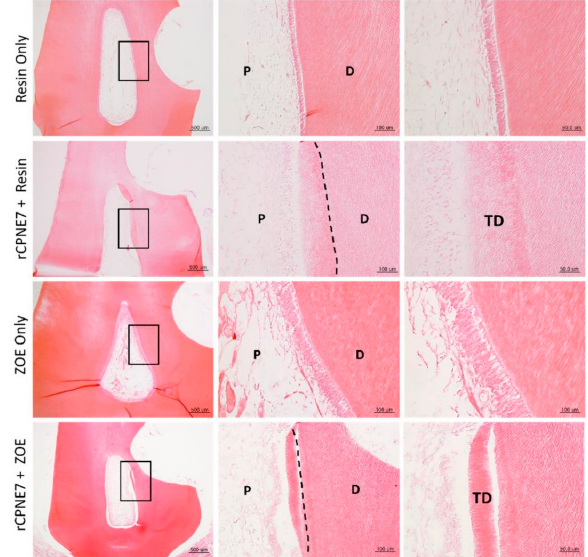
Figure A2. Tertiary dentin formation is not dependent on the filling material used. Histological analysis of dental pulp responses at the cavity preparation areas treated with or without rCPNE7 followed by composite resin or ZOE filling after six weeks by hematoxylin and eosin staining ( n = 6). Dashed line indicates the remaining original dentin/newly formed dentin interfaces. P, pulp; D, dentin; TD, newly formed tertiary dentin.